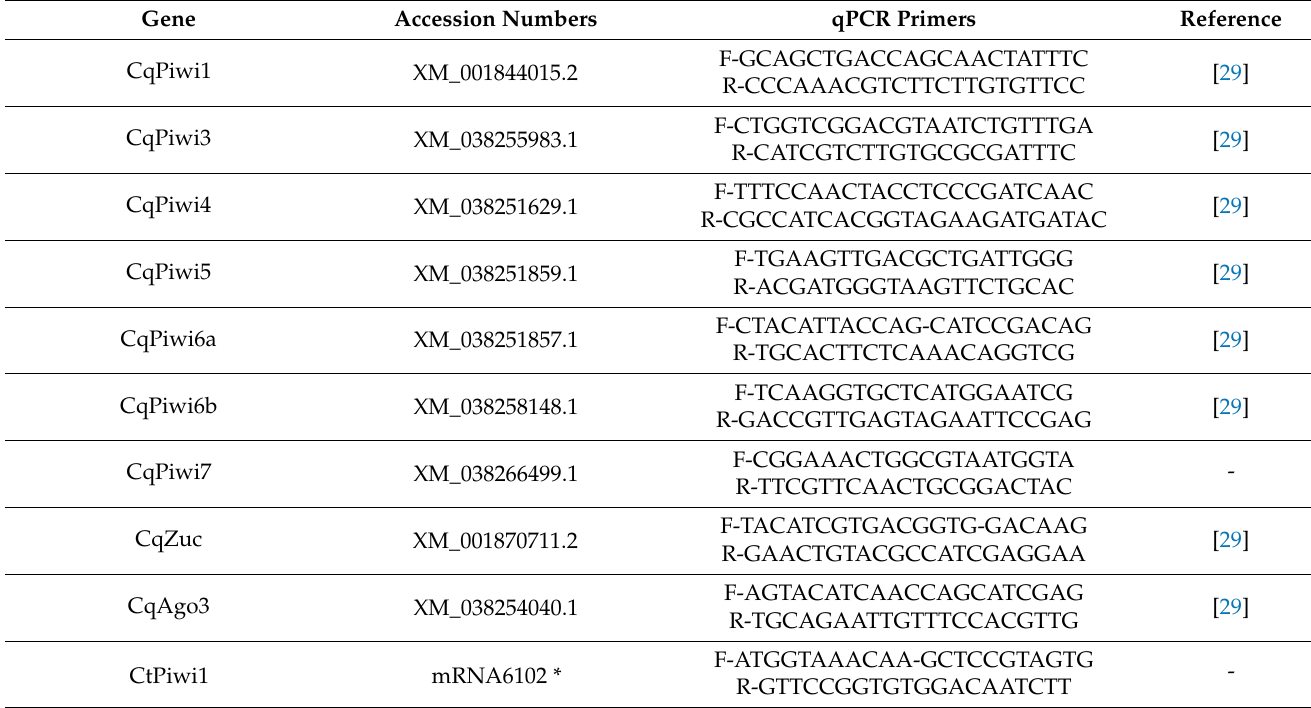
Table 2. Cx. quinquefasciatus (Cq), Cx. tarsalis (Ct), and virus primers for